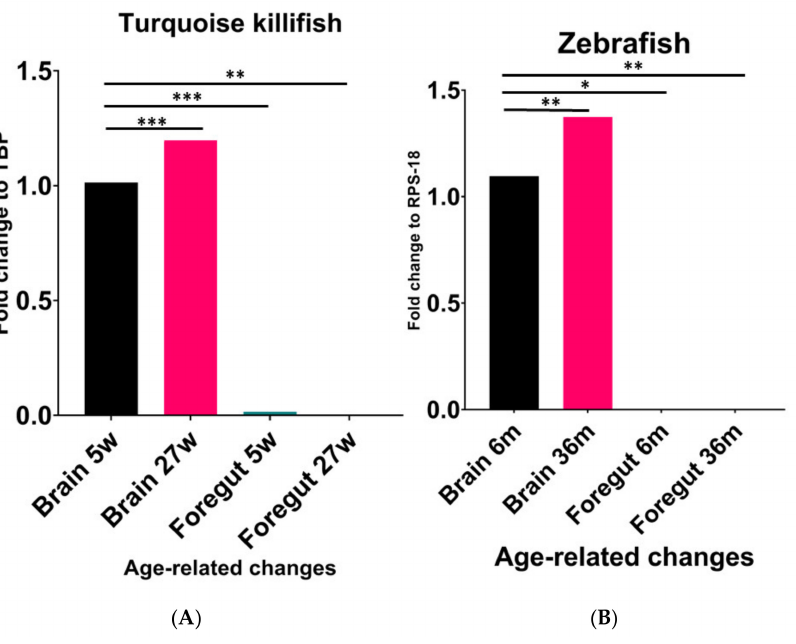
Figure 1. Comparative expression levels of NPY mRNA in the brain and foregut of young and old turquoise killifish ( A ) and zebrafish ( B ). ( A ) Significant increase in NPY mRNA in the brain of 27 wph animals compared to 5 wph ones. Higher expression levels in the brain of animals at 5 wph compared to the levels detected in the foregut of the same animals. ( B ) Significant increase in NPY mRNA in the brain of 36-month-old zebrafish compared to 6-month-old animals. Significant decrease in the foregut compared to the brain either in young or old specimens. * ( p < 0.5), ** ( p < 0.05), *** ( p <